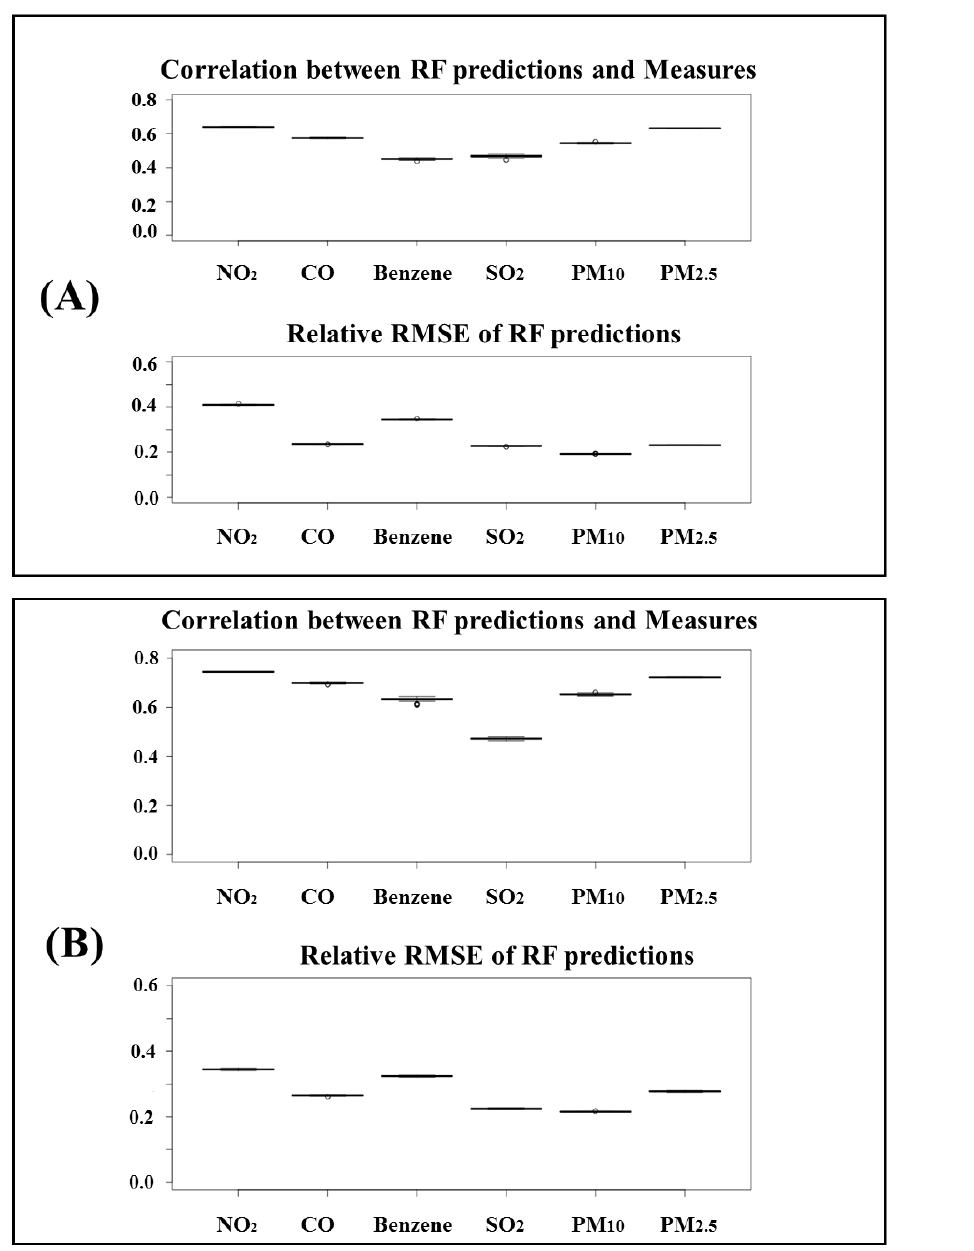
Figure 4. Distributions of the correlation (top) and the relative RMSE (bottom) of random forest predictions vs. measured values for each air quality variable, obtained from 100 repeated 5-fold cross-validation procedures, for the summer ( A ) and winter seasons ( B